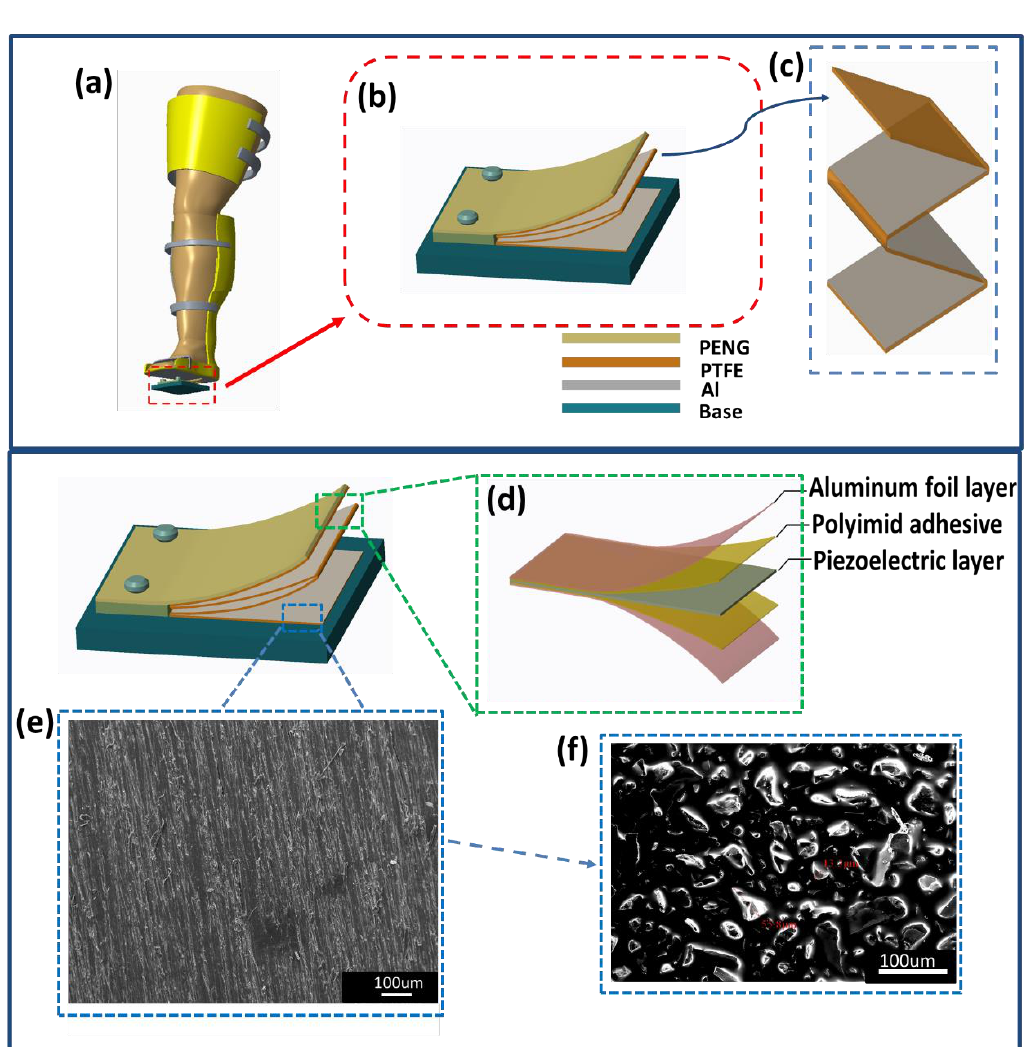
Figure 1. ( a ) The schematic diagram of the self-powered multifunctional sensor (SPMS) under the leg rehabilitation device. ( b ) The material of the sensor is based on a processed stainless steel piezoelectric material and three-layers of polytetrafluoroethylene (PTFE) and Al films. ( c ) Schematic diagram of the spherical triboelectric nanogenerator (TENG) with a multilayered structure. ( d ) A schematic illustration of the functional components of the sensor and the basic diagram of the piezoelectric nanogenerator (PENG) and TENG working methods. ( e ) Scanning electron microscope images of the surface on the PTFE. ( f ) Micromorphology of #1000 grit sandpaper surface.